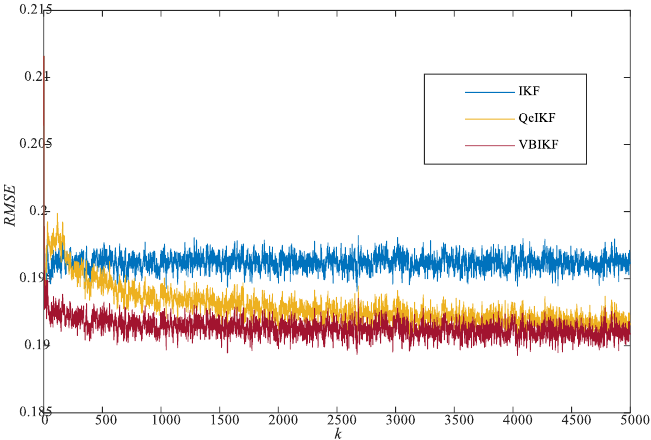
Figure 4. The RMSE k result of the IKF, the QeIKF, and the VBIKF for the scaled ˆ Σ w with α =